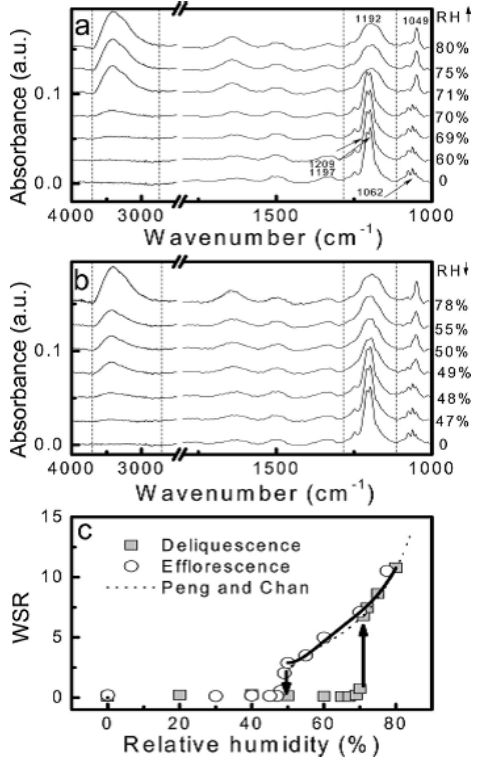
Figure 12. (a) FTIR spectra of CH 3 SO 3 Na particles during humid- ification. (b) FTIR spectra of CH 3 SO 3 Na particles during dehumid- ification. (c) Water-to-solute ratios (WSR) of CH 3 SO 3 Na particles as a function of RH: comparison between WSR measured by Liu and Laskin (2009) using micro-FTIR to those determined by Peng and Chan (2001b) using electrodynamic balance. Reprinted with permission by Liu et al. (2009). Copyright 2009 American Chemi- cal Society.